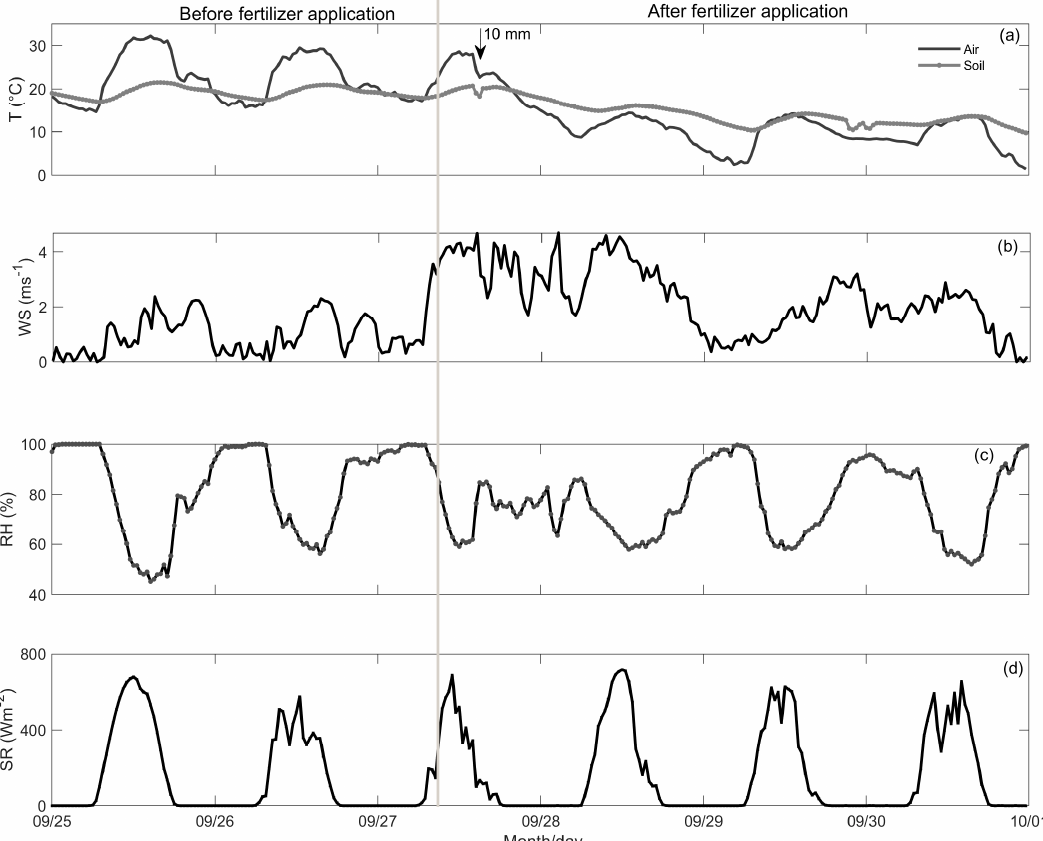
Figure 2. Hourly averages of ( a ) air temperature (black) and soil temperature (gray), ( b ) wind speed, ( c ) relative humidity, and ( d ) solar radiation measured during the field trial. Fertilization occurred at 09:30 on 27 September (vertical line). A rain storm occurred six hours after fertilization.